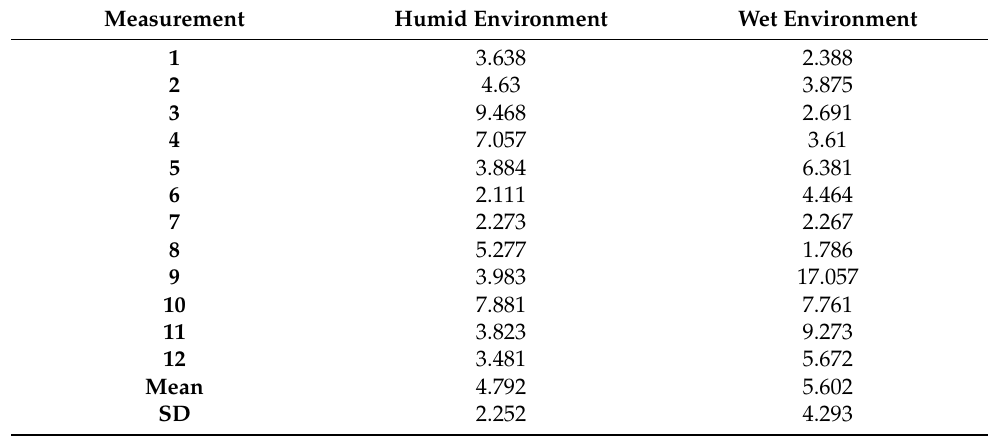
Table 2. Gap measurements at 3 mm between dentinal wall and bioceramic sealer ( µ